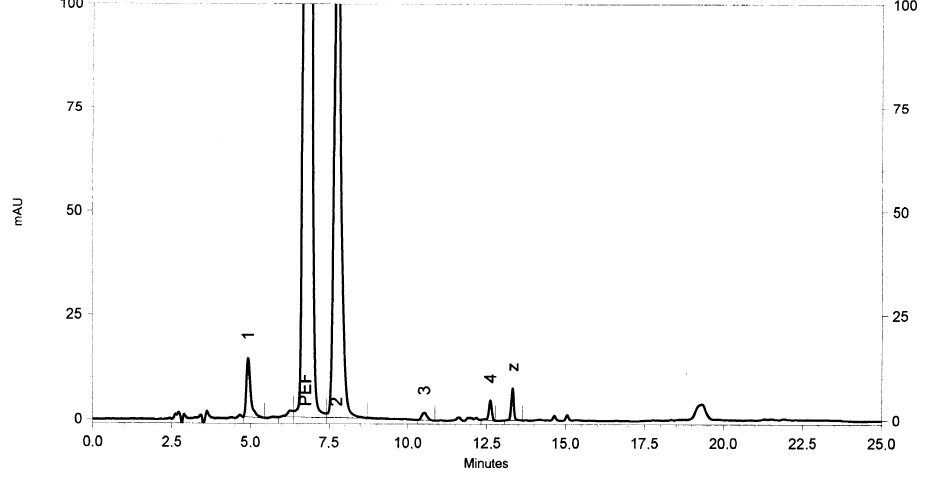
Processes 2022 , 10 , x FOR PEER REVIEW 13 of 23 Figure 8. Chromatogram of the PEF oxidized by ACVA after incubation for 60 h at 60 ◦ C. After 56 days of the incubation of CIP or PEF with H 2 O 2 at room temperature, no peaks from the degradation products were recorded. It suggests that the degradation pro- cess of the tested FQs did not take place under the conditions used. (Figures 9 and 10).